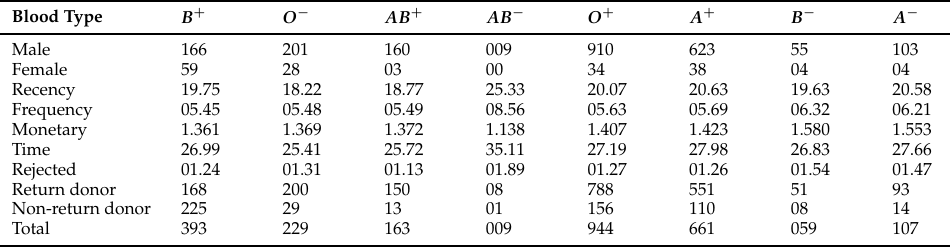
Table 3. Descriptive statistics of the blood donors